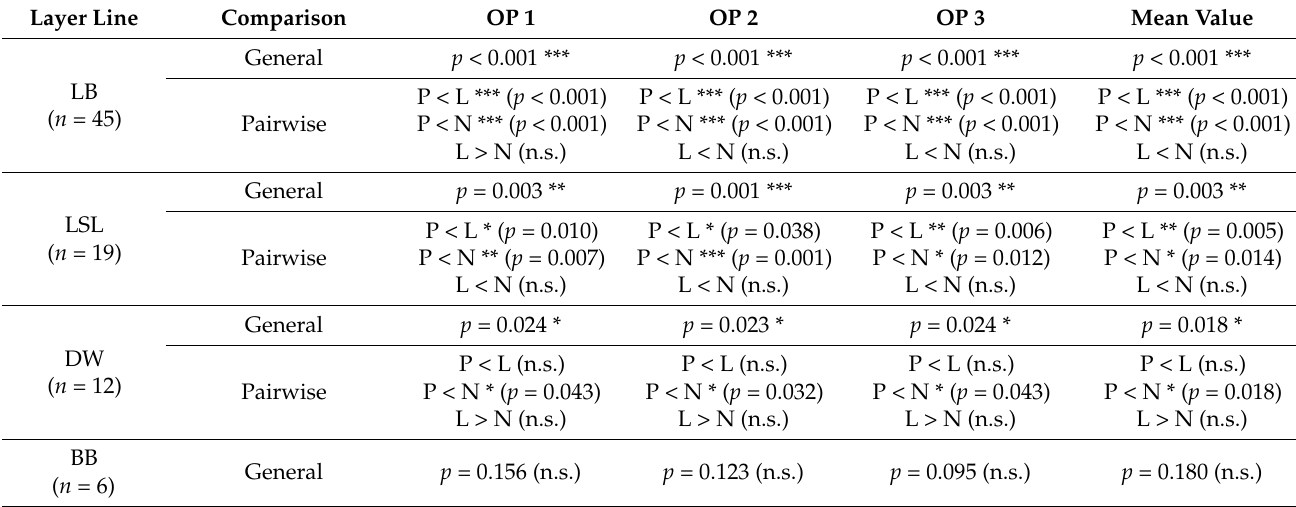
Table 4. Aggressive pecking in the three functional areas, perches (P), litter area (L) and nest-box area (N), shown for Observation Periods (OPs) 1–3 and for the whole laying period (mean value for OPs 1–3) 1